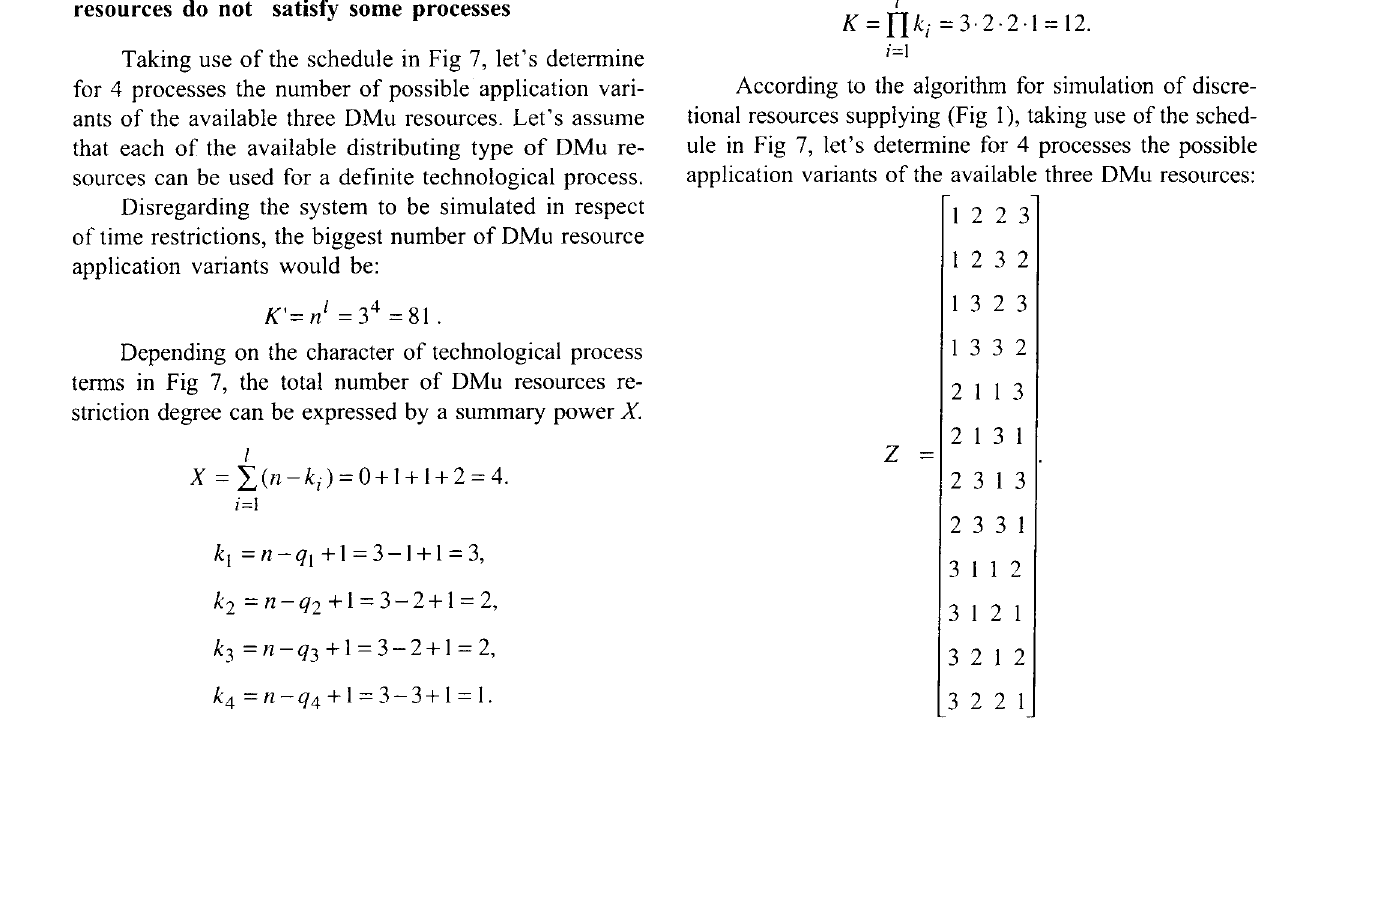
Fig 7. Scheme for specifying discretional resource sup plying degree of simulated system processes, when X=